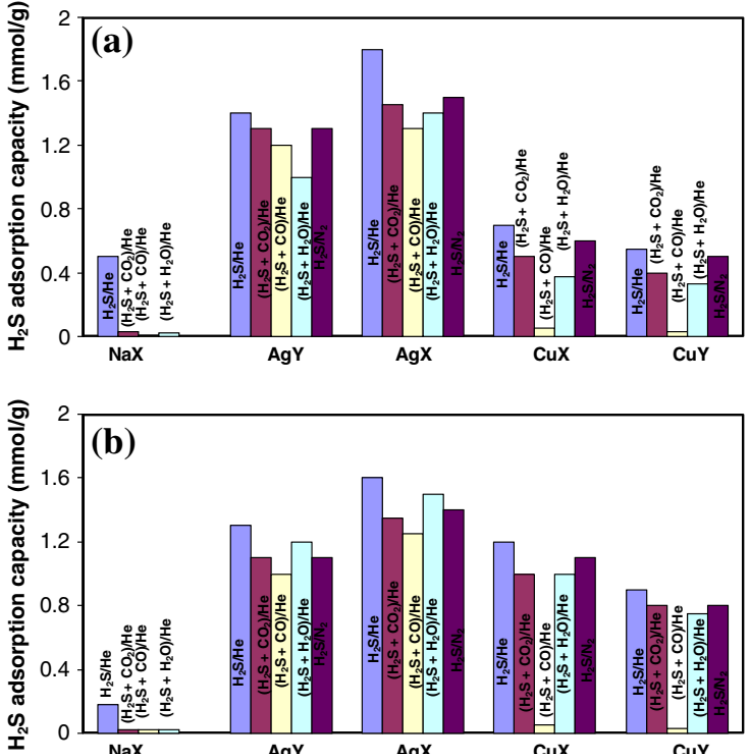
Figure 4. H 2 S adsorption capacities of NaX, AgY, AgX, CuX, and CuY zeolites for 10 ppm H 2 S in He and N 2 in the absence and presence of CO 2 (20%), CO (2%), and H 2 O (2%) in the feed at ( a ) room temperature and ( b ) 150 °C. Reprinted with permission from Ref. [57]. 2011, Elsevier.